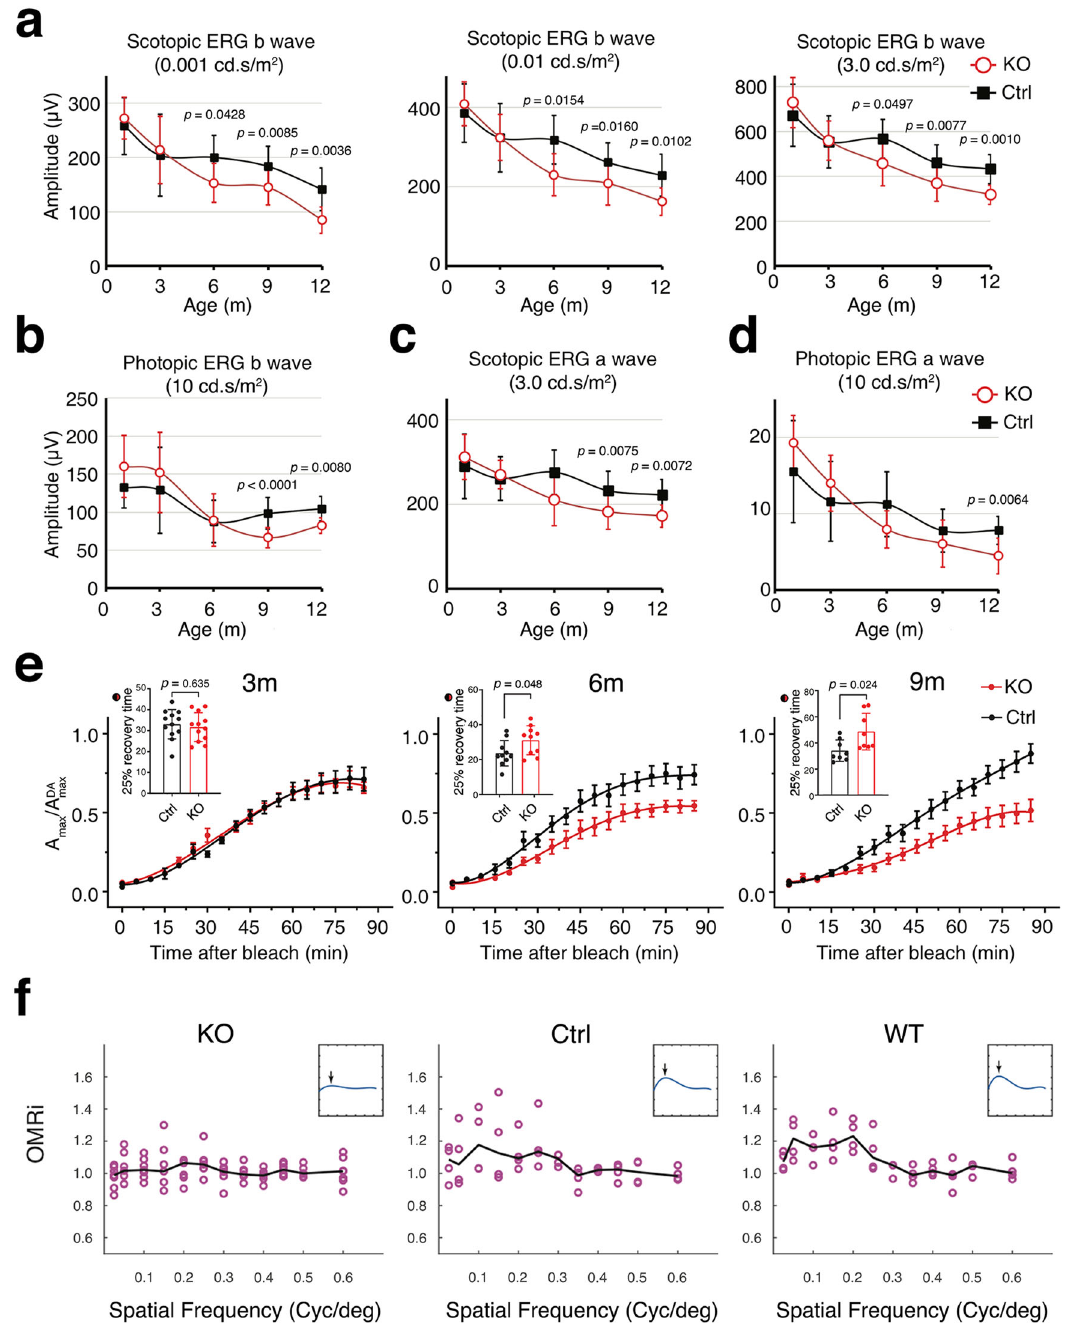
Fig. 1 RPE Δ Clic4 mice developed age-related vision loss. a – d The b-wave ( a , b ) or a-wave ( c , d ) amplitudes of the scotopic ( a , c ) and photopic ( b , d ) ERG response evoked by a fl ash of indicated stimulation intensity are presented. ERG values obtained from Ctrl ( N = 6, 16, 8, 12, and 8 eyes for 1-, 3-, 6-, 9- and 12-month (m)-old mice respectively) and KO ( N = 12, 16, 6, 14, and 8 eyes for 1-, 3-, 6-, 9- and 12-month-old mice, respectively) mouse eyes are shown as Means ± SD. Two-tailed student ’ s t -test. e KO mice had delayed photobleach recovery. After bleaching >90% of rhodopsin at time 0, the recovery of the scotopic ERG maximal a-wave ( A max ) at different time points is shown. Insets show the time required for recovering 25% of A DAmax after bleaching. Results obtained from 3-month-old ( N = 12 eyes), 6-month-old ( N = 10 eyes), and 9-month-old ( N = 8 eyes) Ctrl and KO mice are represented as Means± SEM. Two-tailed student ’ s t -test. f OMR index (OMRi) dependency on stimulus spatial frequency, under scotopic conditions, maximal contrast, and optimal stimulus velocity (12 deg/s), for 9 ± 1.5-month-old KO ( N = 7) and Ctrl ( N = 4) mice as well as 7 ± 1.5-month-old WT ( N = 4) mice. OMRi in y -axis measures the head movements in correct/incorrect direction. Cycles (cyc)/degree (deg) on the x -axis is a measure of spatial frequency. Black lines represent medians across all mice. Insets represent fourth-order polynomial fi ts, at the same scale as the original data. Arrows point at optimal spatial frequency. Source data of ( a – f ) are provided as Source Data.